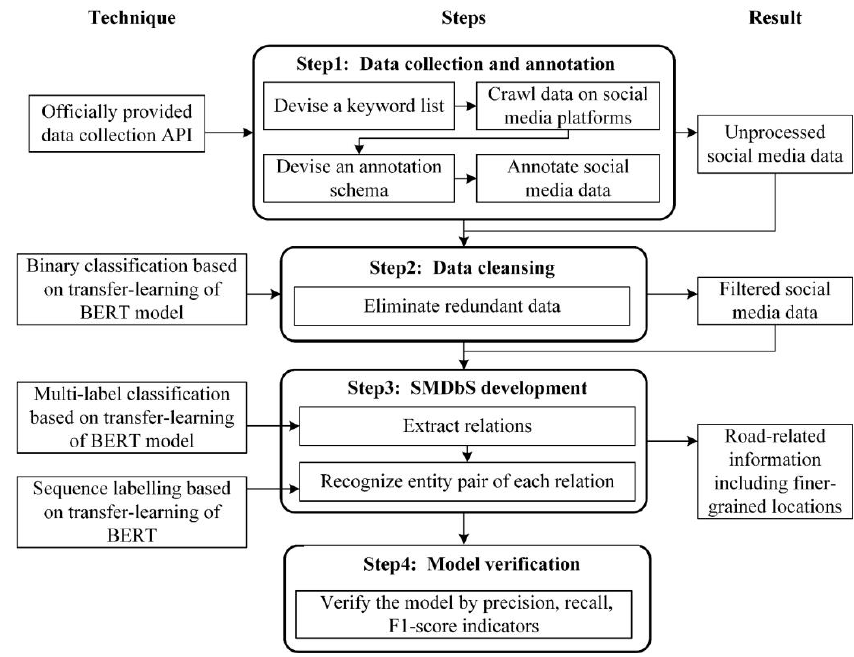
Figure 1. The development of the SMDbS.